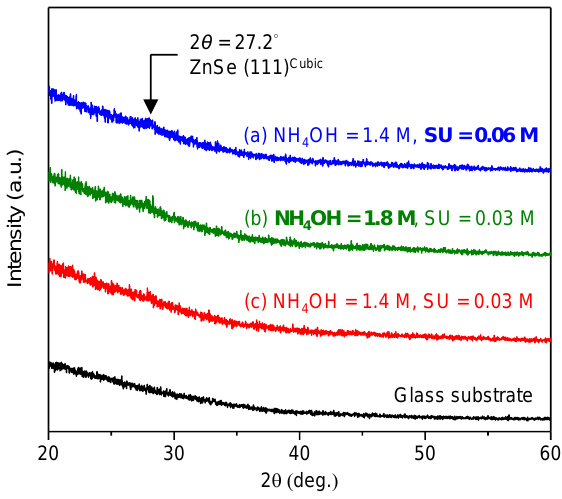
Figure 6. XRD patterns of a soda-lime glass substrate and Zn(Se,OH) films deposited with ( a ) ammonia concentration of 1.4 M and selenourea concentration of 0.06 M; ( b ) ammonia concentration of 1.8 M and selenourea concentration of 0.03 M and ( c ) ammonia concentration of 1.4 M and selenourea concentration of 0.03 M.